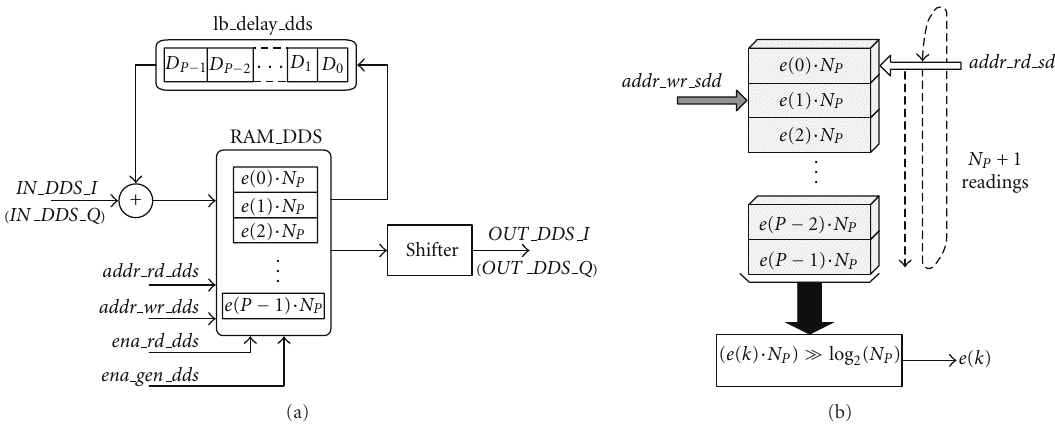
Figure 7: Data-dependent sequence generator submodule. (a) Simplified architecture; (b) pictorial representation of the e ( k ) sequence